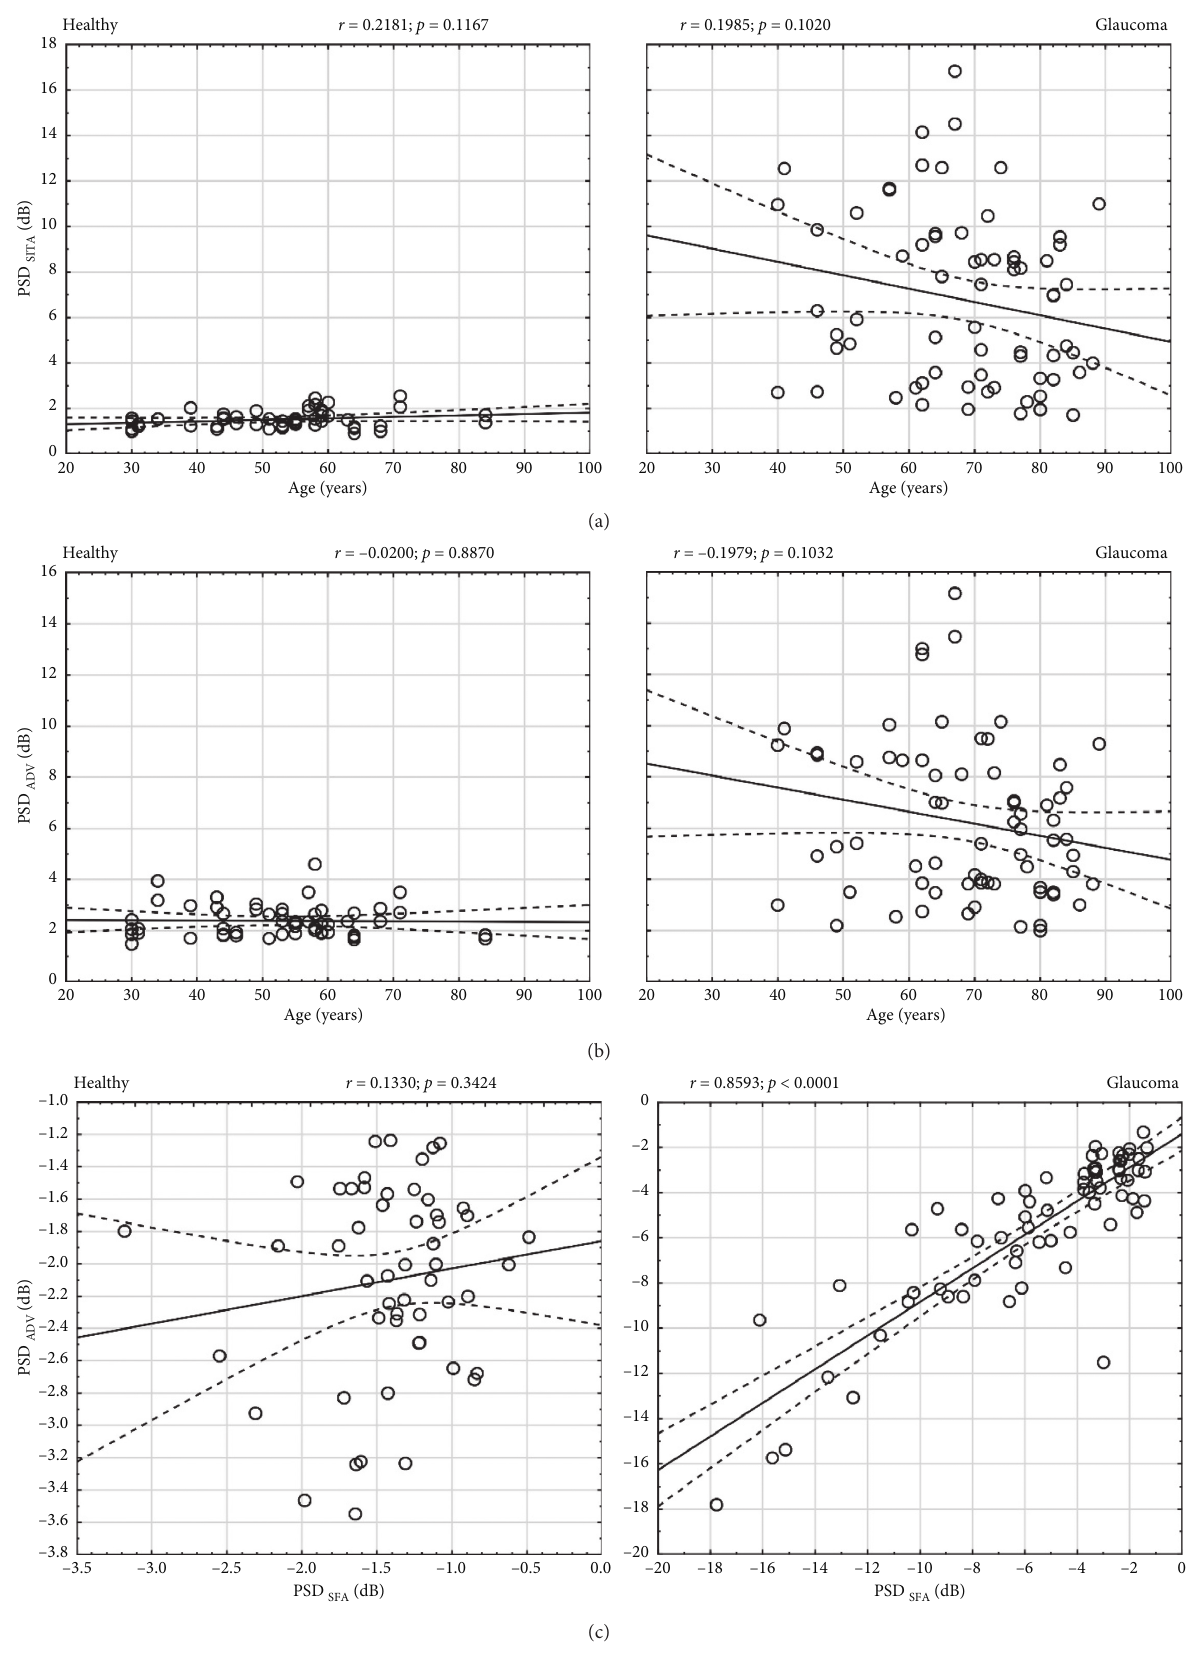
Figure 8: The analysis of pattern standard deviation in healthy and glaucomatous eyes. (a, b) Correlation of PSD with patient age for SFA and ADV strategies; (c) correlation between PSD in ADV and SFA